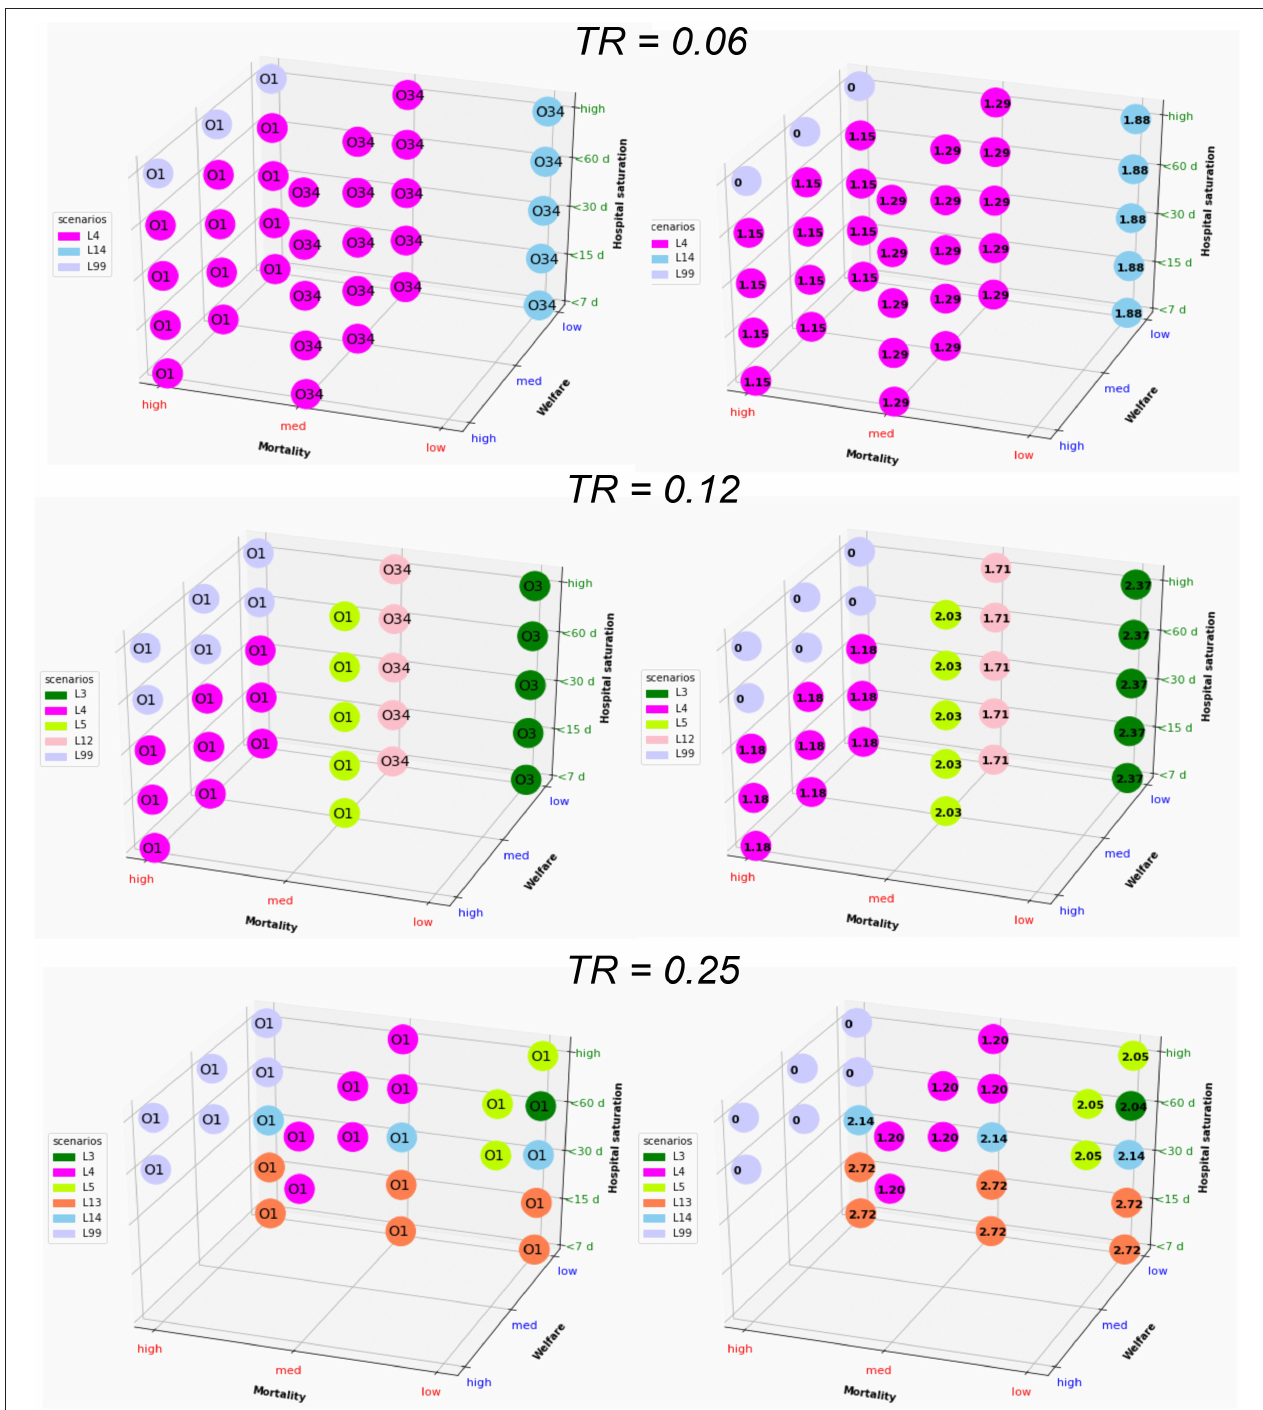
FIGURE 5 | Graphical representation of the optimal solution depending on the strength of the constraint for a whole period of 300 days. The results in the right column are expressed as direct cost (in billion euros); Tr, transmission rate. The optimal solution that minimizes the overall economic impact under a set of constraints is found in the foreground (low mortality, high welfare, and low